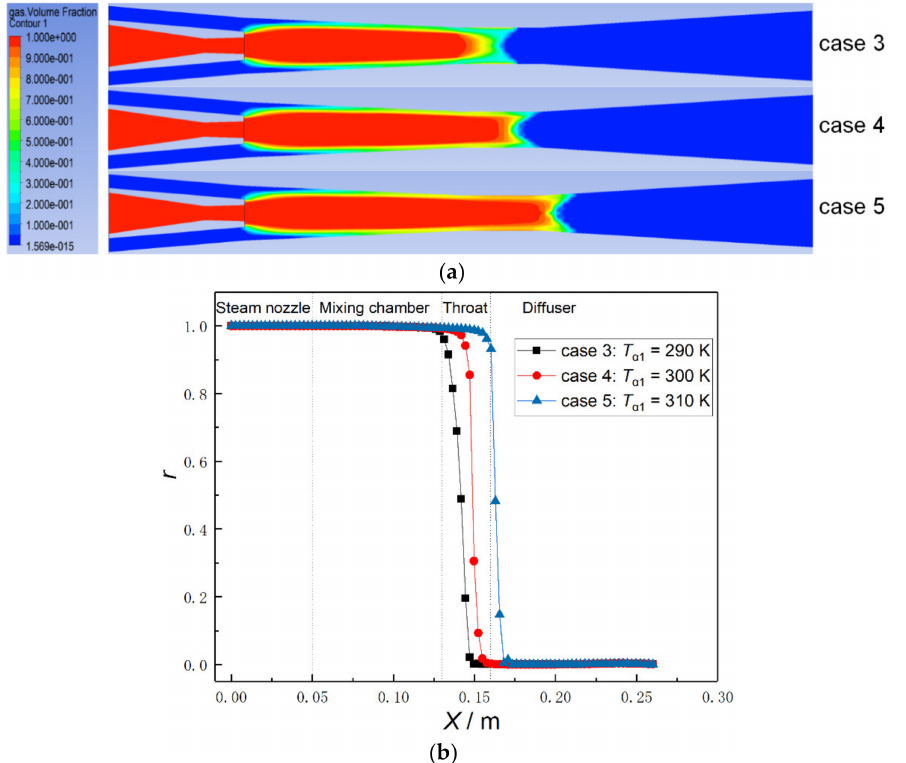
Figure 9. Effect of water inlet temperature T α 1 on steam volume fraction. ( a ) Contours of steam volume fractions at different water inlet temperatures; ( b ) Axial profiles of steam volume fractions at different water inlet